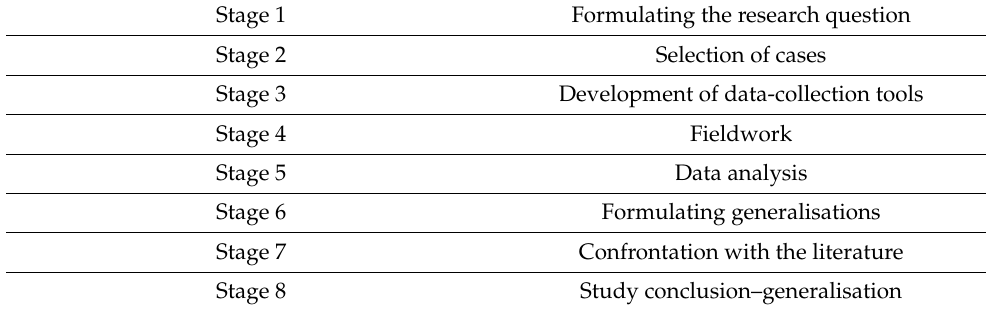
Table 1. Case study